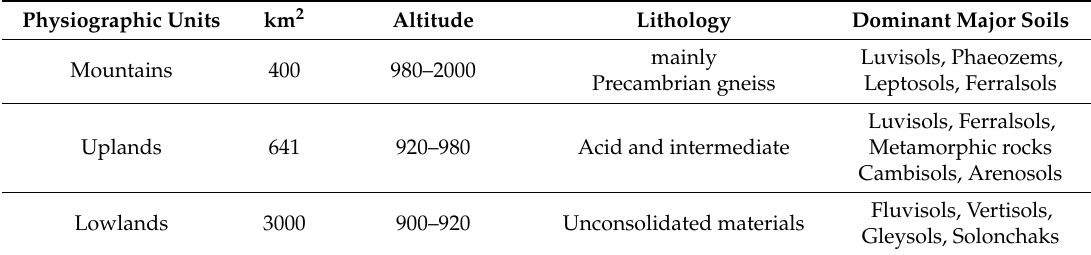
Table 1. Main Physiographic Units and Soils in Kongwa District.